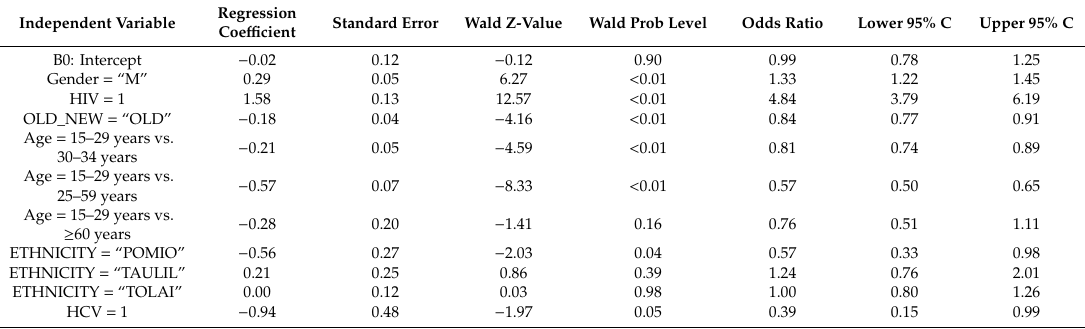
Table 4. Multivariable logistic regression model 2 (excluding district) for risk factors associated with HBsAg positive blood donors in ENBP,